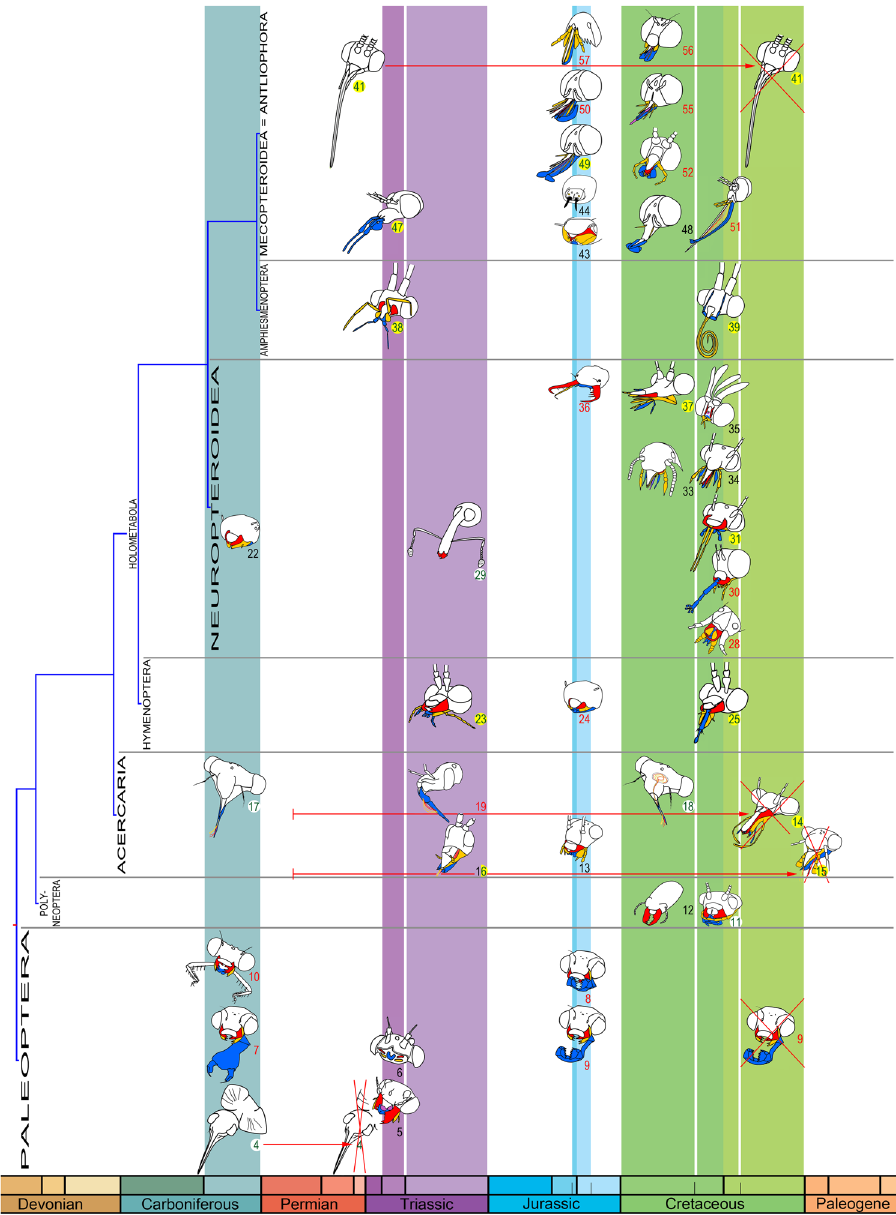
Figure 3. Mouthpart types supporting the six main geological periods of changes in insects. Mouthpart types are schematic (not a species in particular). Colour codes: red: mandibles, orange: maxillae, blue: labium. Numbers correspond to the characters in Matrix Table S1, red: predator types, green: phytophagous types, black undefined or omnivorous types, yellow circles: types feeding on flowers (pollen and/or nectar), white circles: types not feeding on flowers. Mouthpart type 2 is not represented during ‘Late’ Cretaceous as it corresponds to a Hexapoda but not an Insecta. Types 4 and 41 represented for Late Permian and type 15 for Paleocene because they support the hierarchy (discussed in main text). Crossed mouthparts correspond to extinctions. Red arrows: time of duration of extinct mouthpart types. The phylogeny of superordinate taxa is based on 54 . Copyright